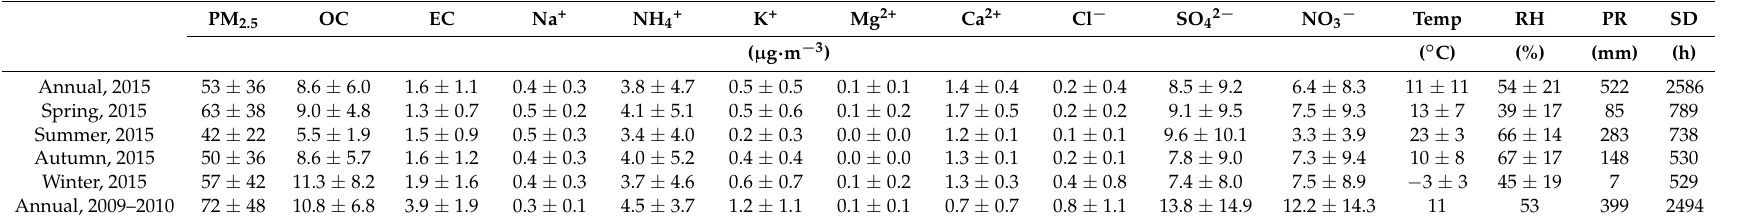
Table 1. Statistics of the determined chemical compositions in PM 2.5 and selected meteorological factors in Shangdianzi